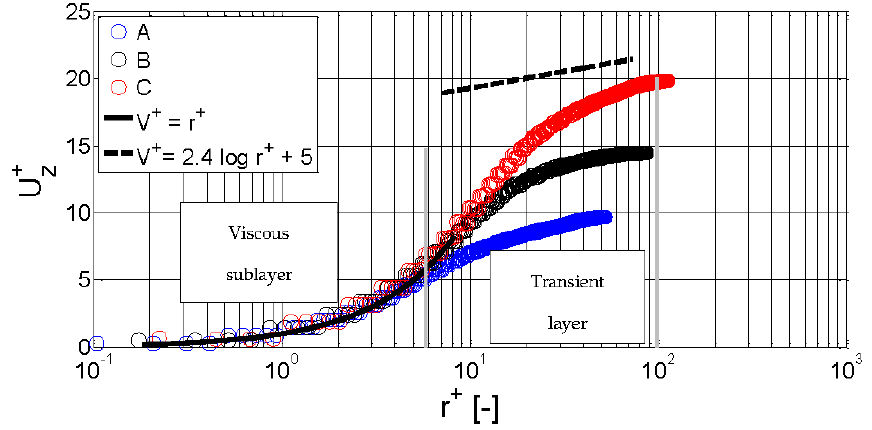
Figure 12. Logarithmic boundary layer profiles for the rotating wall.